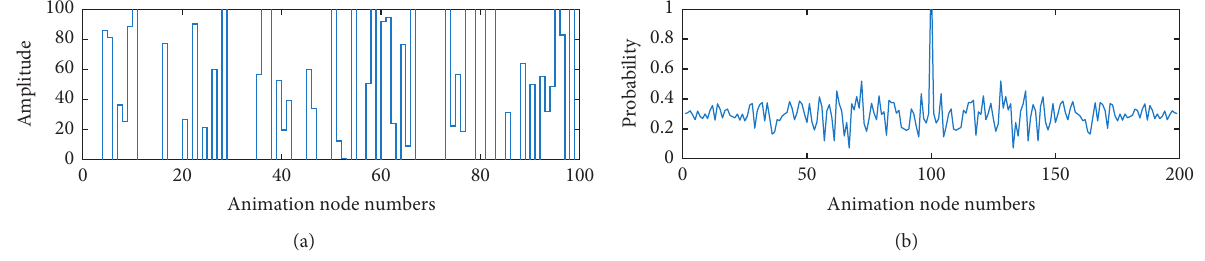
Figure 5: Probability distribution of node numbers after multivisual animation sample